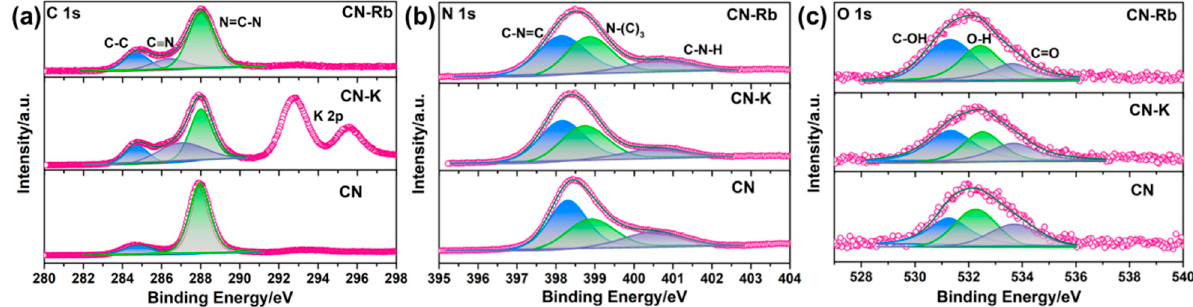
Figure 2. ( a ) High-resolution XPS spectra of C 1s of obtained PCN. ( b ) High-resolution XPS spectra of N 1s of obtained PCN. ( c ) High-resolution XPS spectra of O 1s of obtained PCN.